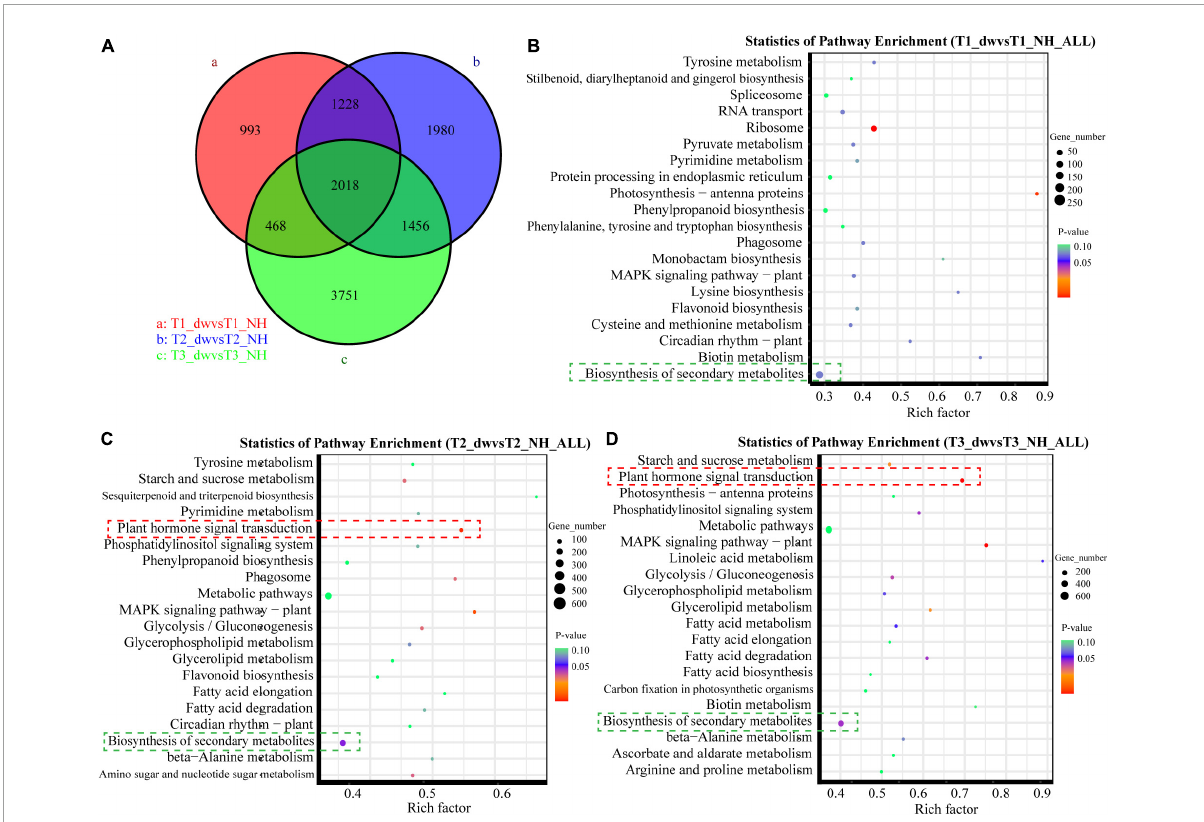
FIGURE2 Venn diagram and KEGG function analysis of DEGs in T1, T2, and T3 groups. (A) Venn diagram of DEGs in three groups. Panels (B–D) are scatter plots of the first 20 KEGG enrichment pathways of DEGs at T1, T2, and T3 stages,